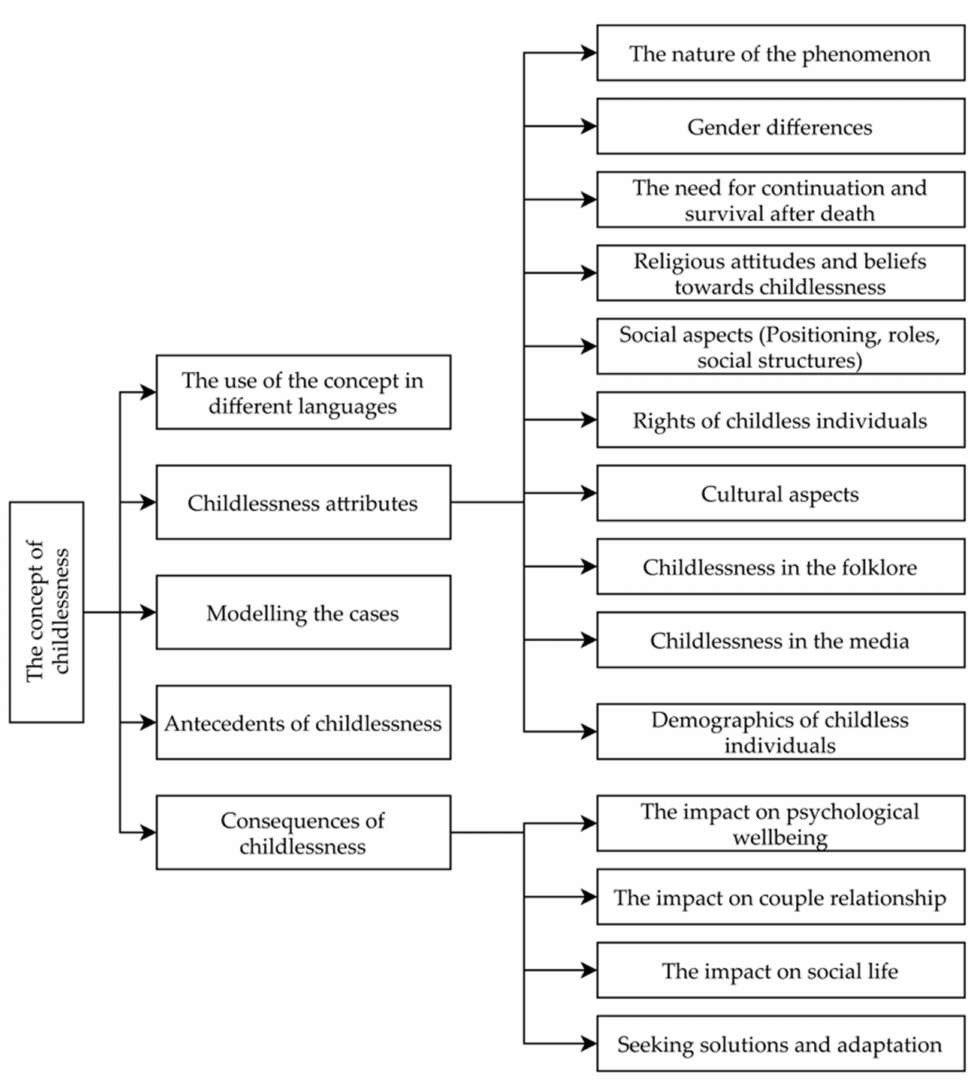
Figure 4. A conceptual map of the results of childlessness concept